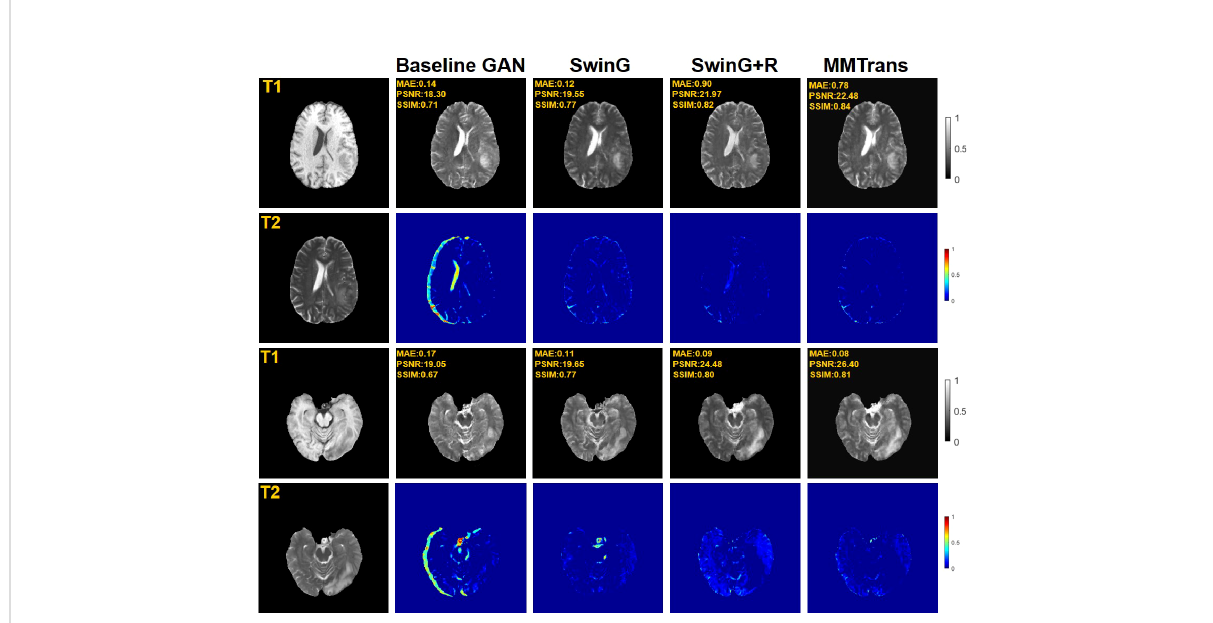
FIGURE 9 Qualitative results in ablation studies under different scenarios on the BraTs2018